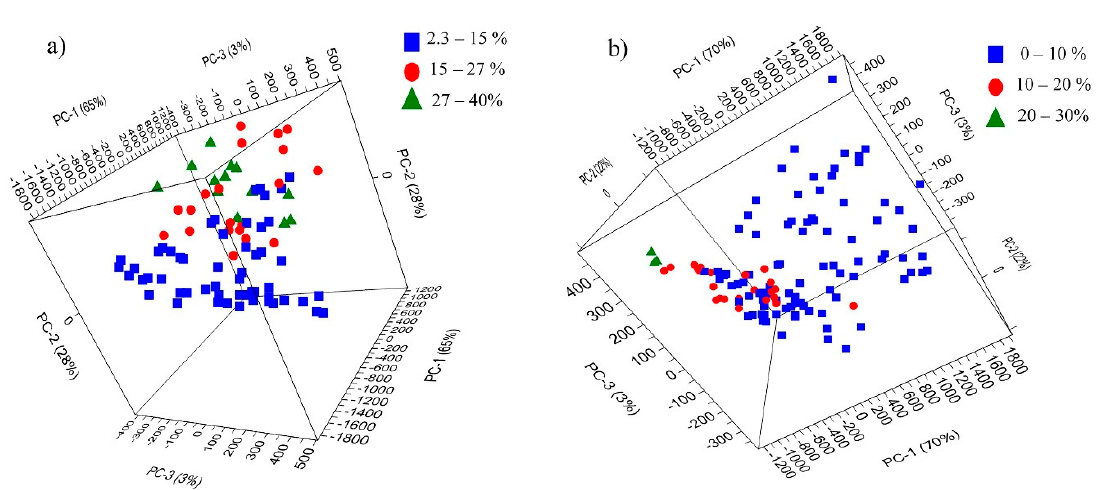
Figure 4. Principal Component Analysis (PCA) model score plots of ( a ) the Fe concentration categorized into three ranges; and ( b ) the combined Pb–Zn concentration categorized into three ranges (the concentrations are expressed in wt.%).